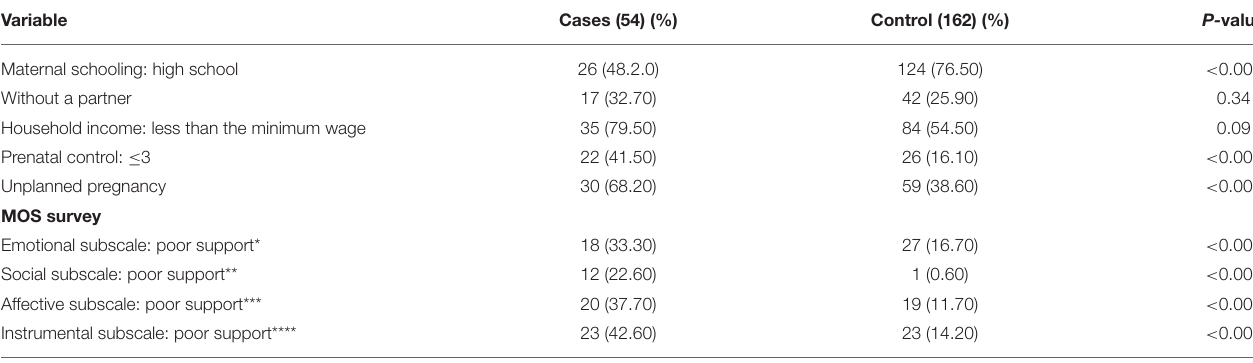
TABLE 2 | Description of social